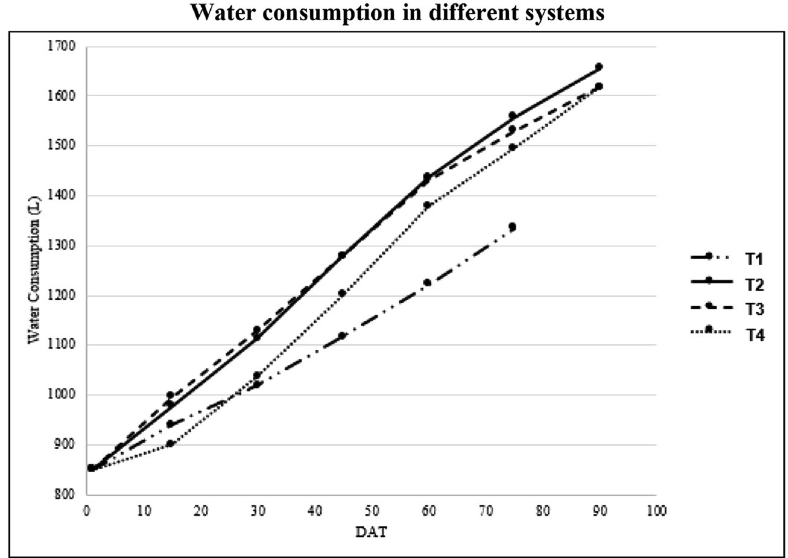
Figure 4. Water consumption during the three cuts. T1 Deep water culture, T2 October, T3 Beni suef, T4 Fayoum, DAT Days after